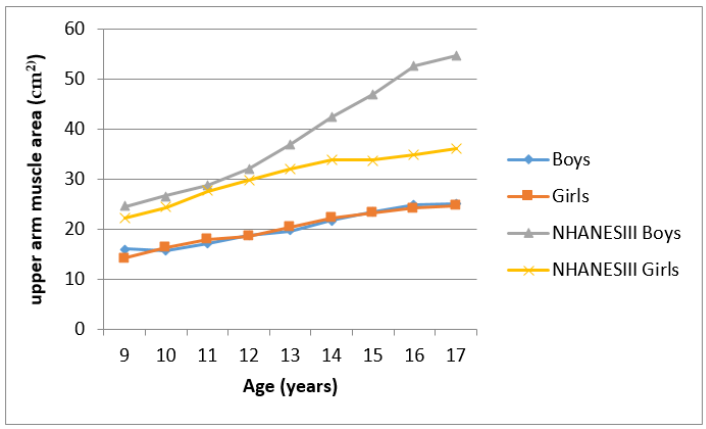
Figure 3. Mean upper arm muscle area of Ellisras population compared to the NHANES III reference population aged 9–17 years.